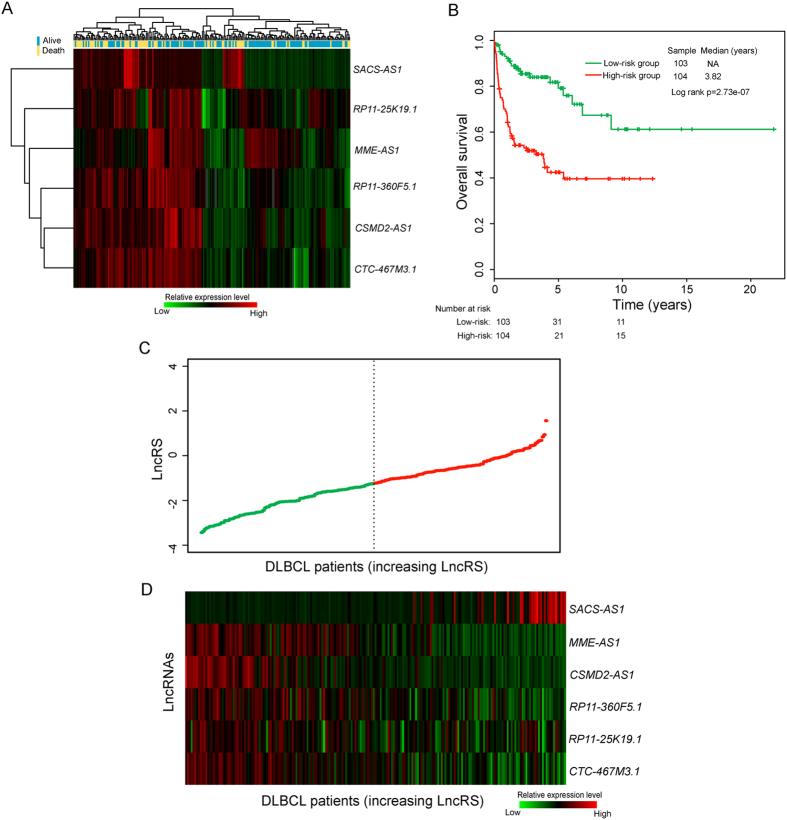
Prognostic evaluation of the six-lncRNA signature in the discovery series.(A) Hierarchical clustering analysis for 207 DLBCL patients based on expression levels of six prognostic lncRNAs in the discovery series. (B) Kaplan–Meier survival curves for patients in the discovery series. (C) The distribution of LncRS. (D) The expression heatmap of six prognostic lncRNAs.